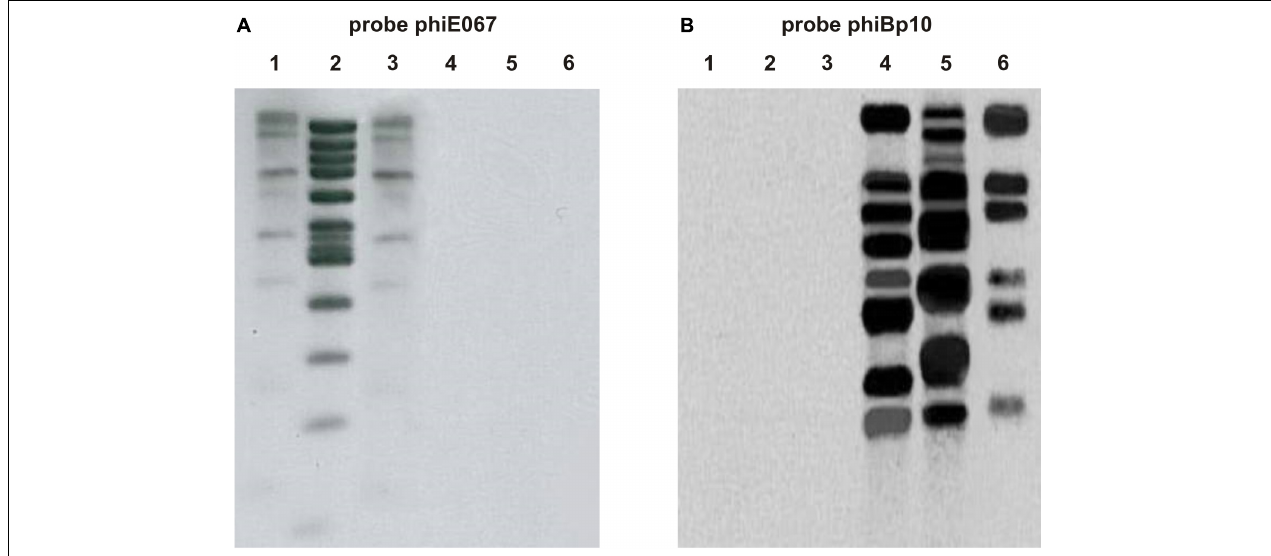
FIGURE 2 | Hybridization of the isolated Burkholderia phages to (cid:56) E067 (A) and (cid:56) Bp10 (B) . Phage DNAs were cleaved with EcoRI. Lane 1, (cid:56) E058; lane 2, (cid:56) E067; lane 3, (cid:56) E131; lane 4, (cid:56) E202; lane 5, (cid:56) Bp10; and lane 6, (cid:56) 1026b.